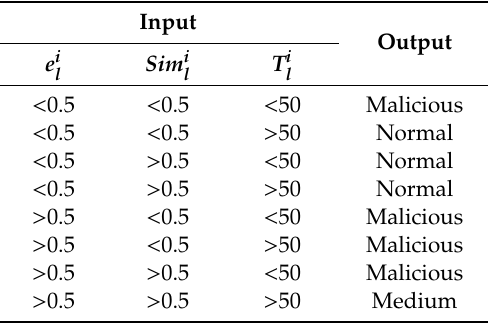
Table 2. Fuzzy rules deployed in the